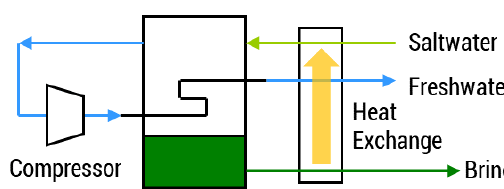
Figure 4. Mechanical vapor compression (MVC).